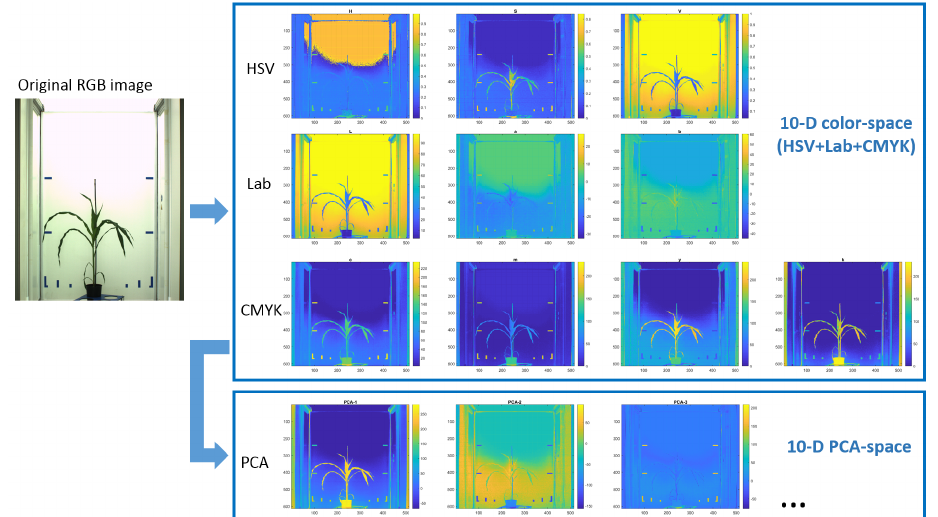
Figure 3. Color-space transformations of plant images in the kmSeg tool. First, original RGB plant images are transformed to a HSV+CIELAB+CMYK 10-dimensional color space. Then, principle components of 10-dimensional image representation are determined. Bottom raw shows first three principle components